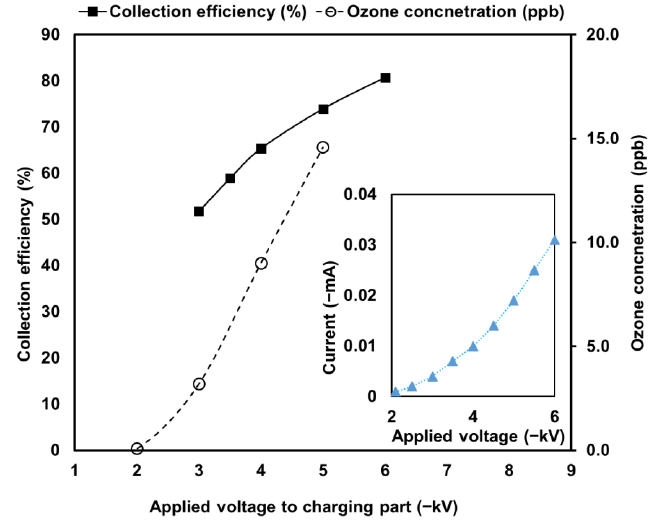
Figure 6. Corona discharge currents (inset), PM collection efficiencies, and ozone concentrations with the increase in the applied voltage to the charging part.